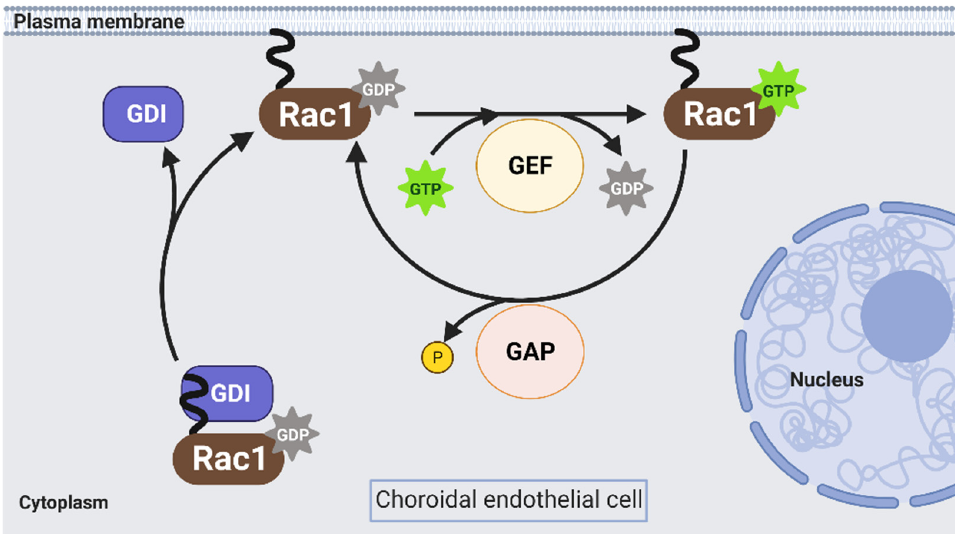
Figure 2. Rac1 GTPase acts as a biologic switch in choroidal endothelial cells. Rac1 GTPase cycles from an inactive, guanosine diphosphate (GDP)-bound, state to an activated, guanosine triphosphate (GTP)-bound, state. The primary regulators of Rac1 activation are GDP dissociation inhibitors (GDIs), guanine nucleotide exchange factors (GEFs), and GTPase activating proteins (GAPs). GDIs prevent the translocation of inactive Rac1 to the plasma membrane by interacting with lipid moieties on Rac1 (e.g., farnesyl or geranylgeranyl lipids). GEFs activate Rac1 by replacing bound GDP on Rac1 with GTP. GAPs inactivate Rac1 by accelerating the hydrolysis of bound GTP on Rac1 to GDP. Solid black lines represent direct interactions (image created with BioRender.com).